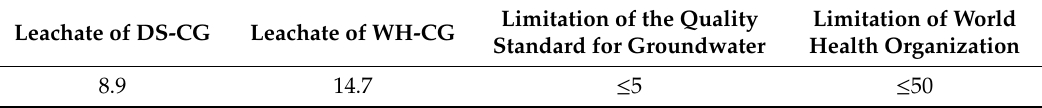
Table 5. Cumulative concentration of Cr and its limitations ( µ g /